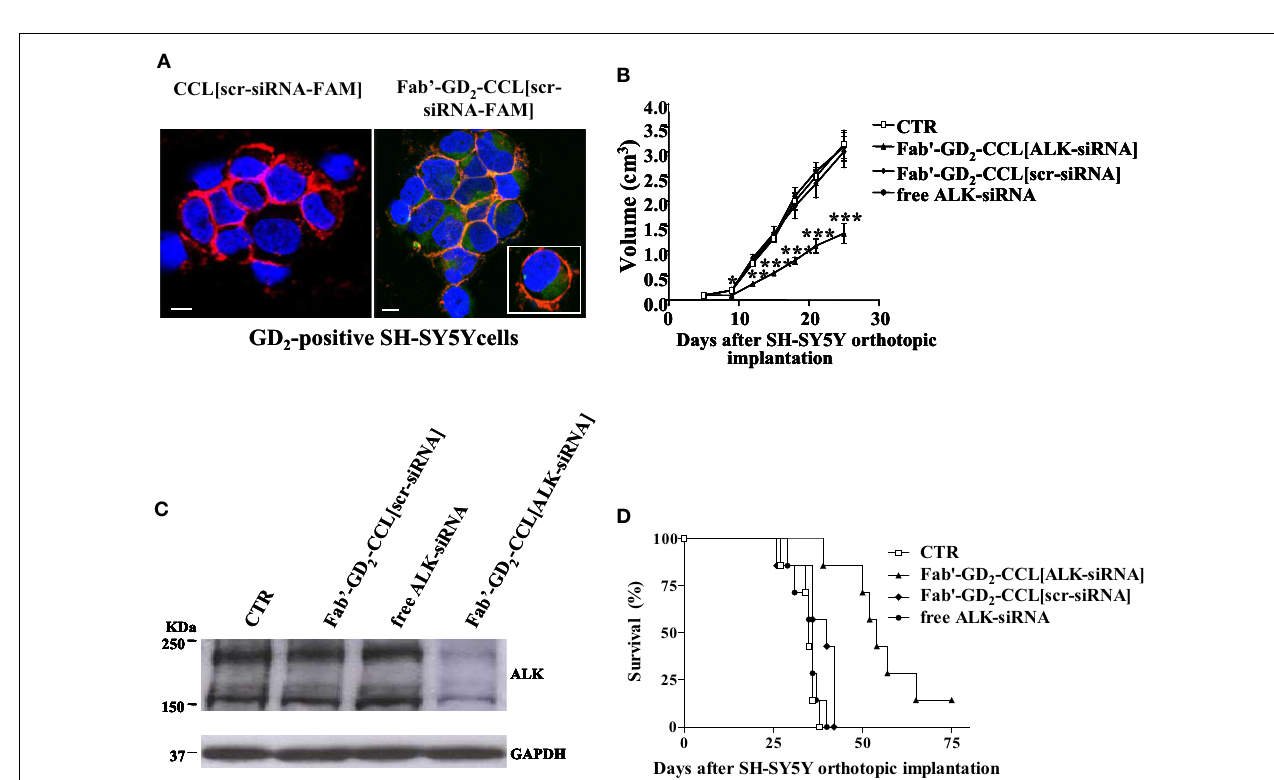
microscope. Bars: 50 µ m. (B–D) Tumor growth inhibition in vivo by ALK-siRNA encapsulated in Fab (cid:48) -GD 2 -CCL. SCID-bg mice ( n = 8) were orthotopically injected with 1.5 × 10 6 SH-SY5Y cells in the capsule of the left adrenal gland. Seven days after the tumor implantation, mice were treated, two-time a week for 3weeks with ALK-siRNA, either free or encapsulated in GD2-targeted nanocarriers [Fab (cid:48) -GD 2 -CCL(ALK-siRNA)]. Another group of mice received a scrambled (scr) siRNA-loaded nanoparticles [Fab (cid:48) -GD 2 -CCL (scr-siRNA)] as control or HEPES-buffered saline (CTR).Tumor expansion over time measured by calipers (B) and survival times (D) were used for determination of the treatment efficacy. (C) The day after the last treatment (25day), tumors from three mice per group were recovered for western blot analyses and ALK protein expression. * P < 0.05; ** P < 0.01; *** P < 0.001, Fab (cid:48) -GD 2 -CCL(ALK-siRNA) vs. Fab (cid:48) -GD 2